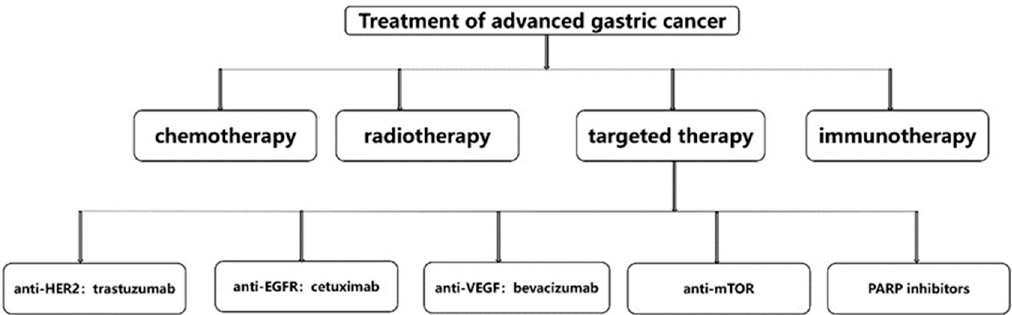
Figure 2. Treatments for advanced gastric cancer.